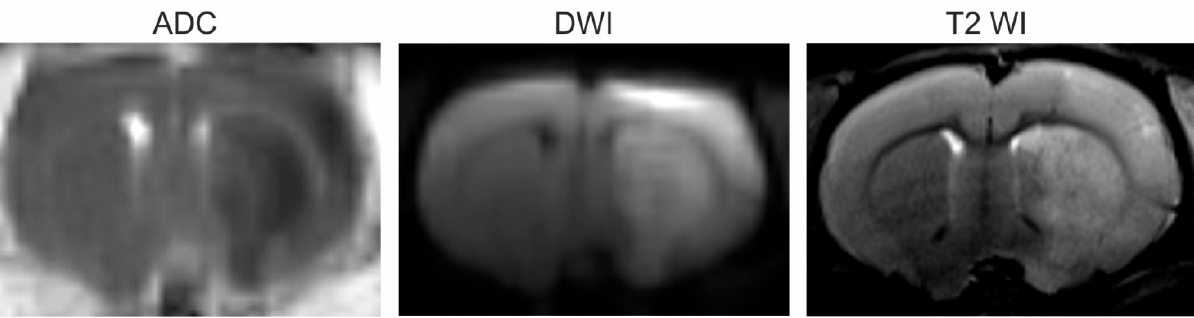
Figure 1. MRI of ischemic foci 24 h after tMCAO. DWI with an ADC map and T2 WI scans show a subcortical localization of ischemic injury in the ipsilateral cerebral hemispheres in rats after tMCAO.